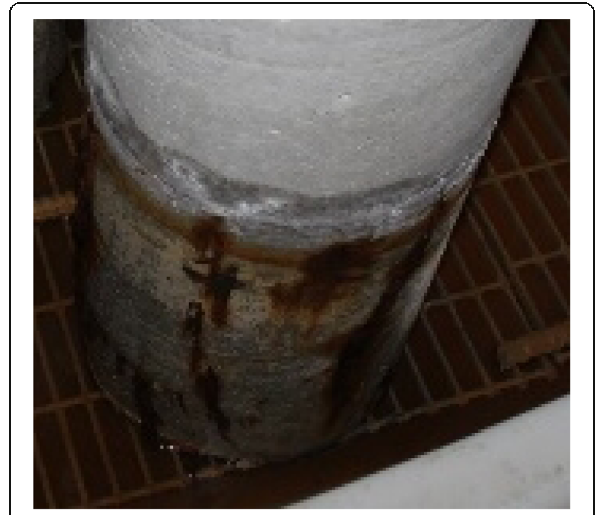
Fig. 5 External signs of corrosion on day 11 for specimen NN-R-1